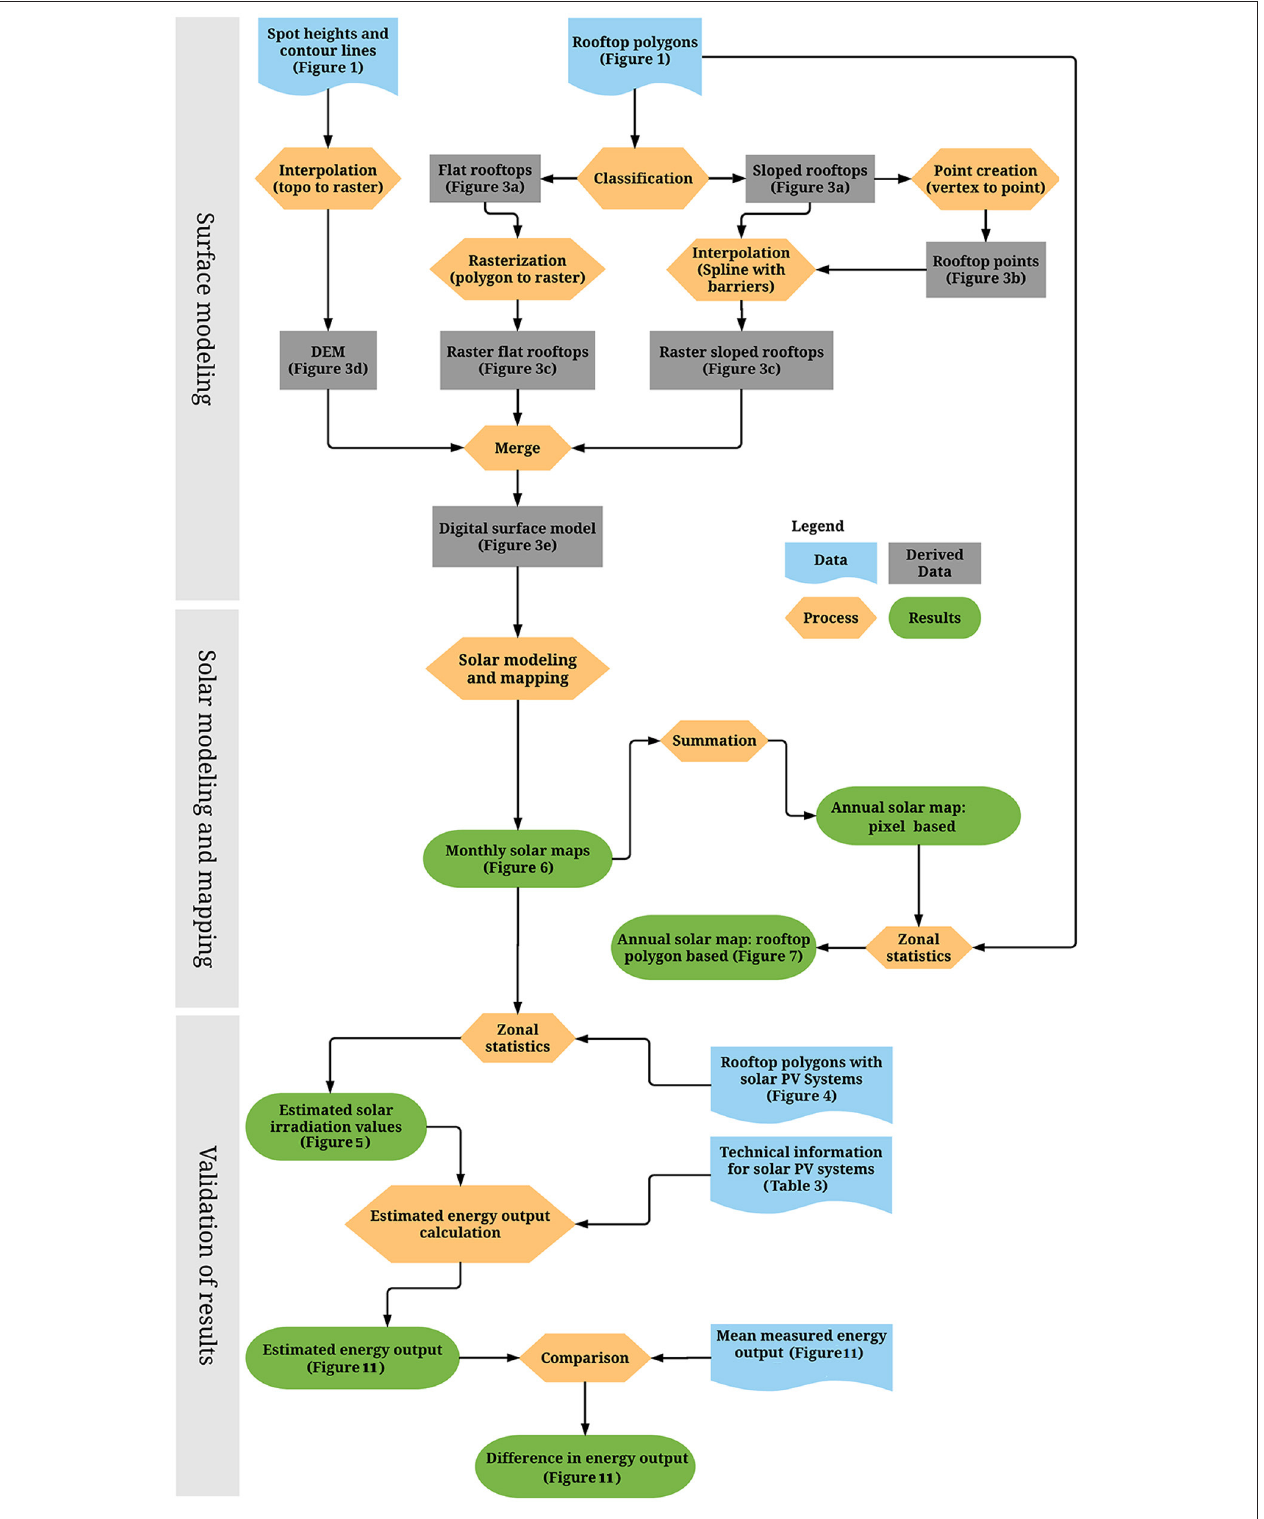
FIGURE 2 | Workflow for the proposed method with three main steps: (i) surface modeling, (ii) solar modeling and mapping, and (iii) validation of results.